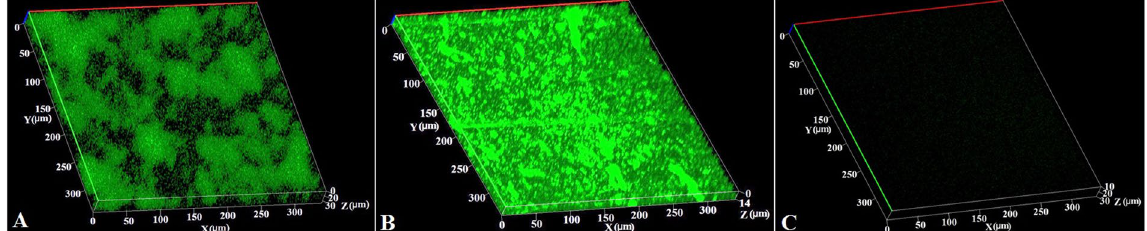
Figure 9. CLSM images showed antibiofilm activity of the Nm-PHB film. Control surfaces such as glass slide ( A ) and µ slide ( B ) shows 100% coverage of biofilm formed by MDR S . aureus . Image C is showing the antibiofilm effect of Nm-PHB film, which showed no indication of biofilm formed by S . aureus